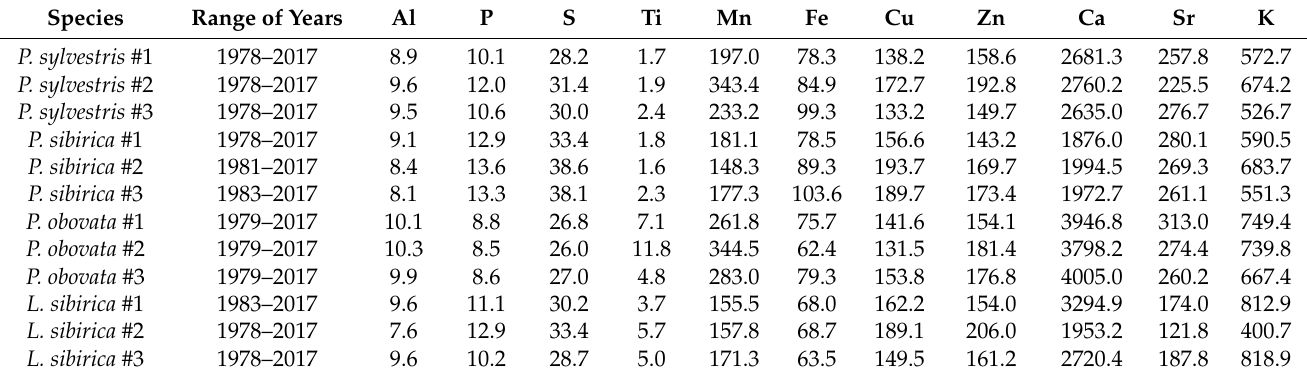
Table A1. Elemental contents in trees under study, mean counts for no treatment case.